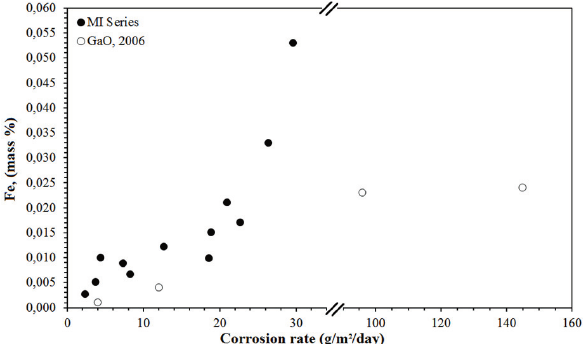
Figure 11. Fe content in refined Mg ingots-corrosion rate relationship. (Comparison of MI series refined Mg and study of Gao et